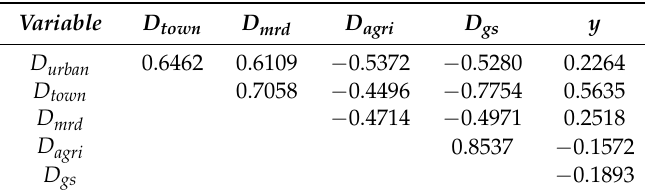
Table 2. Correlation matrix of spatial